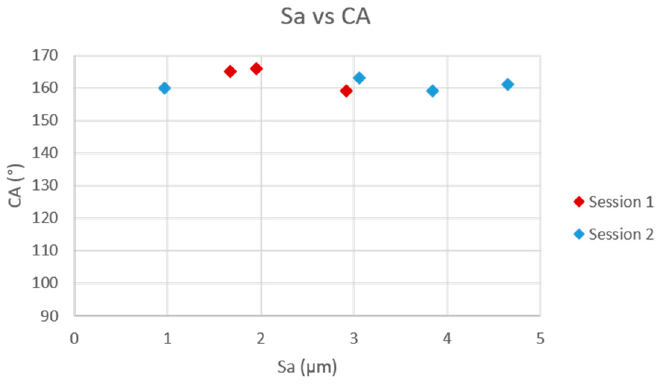
Figure 3. Contact angle (CA) of the samples of the two session with respect to surface roughness (Sa) before immersion. Red dots—session 1, blue dots—session 2.